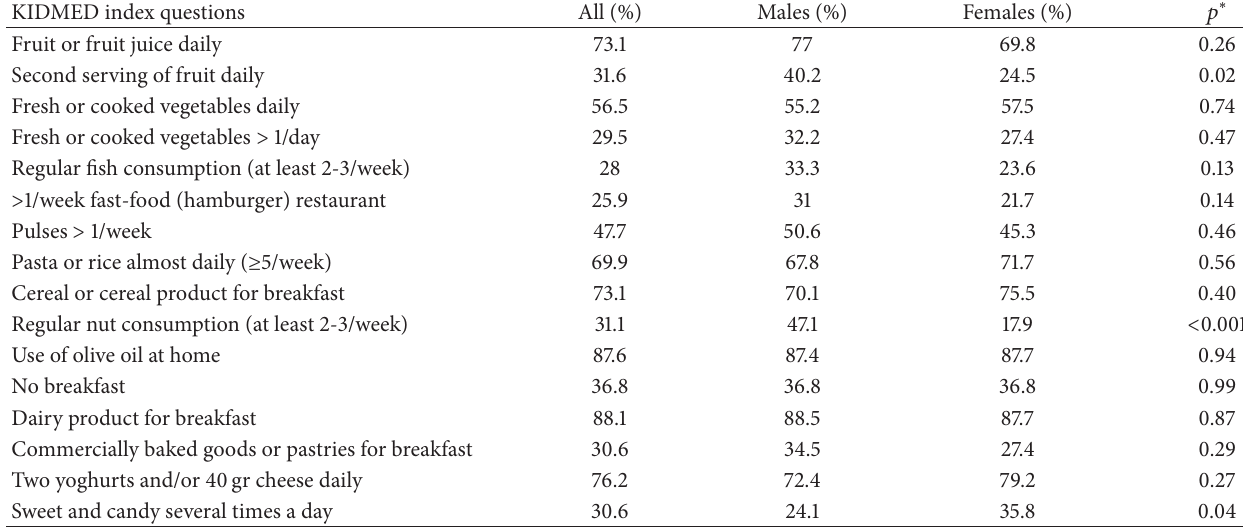
Table 3: KIDMED index questions in all and men and women separately. Positive answers are given as percentages (%). KIDMED index